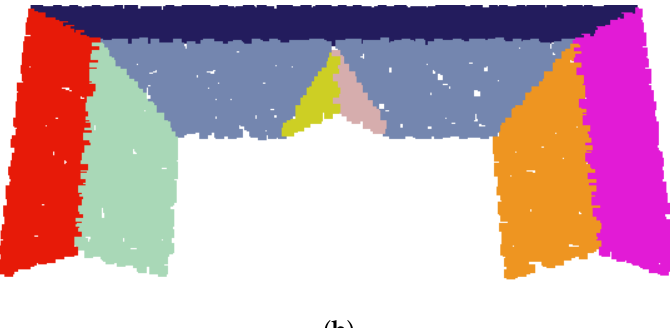
Figure 3. A segmentation of a LiDAR point cloud, where the LiDAR points on top ( a ) are coloured by their height and the LiDAR points on the bottom ( b ) in regard to which roof face they correspond to. The point cloud belongs to the same building as the base model from Figure